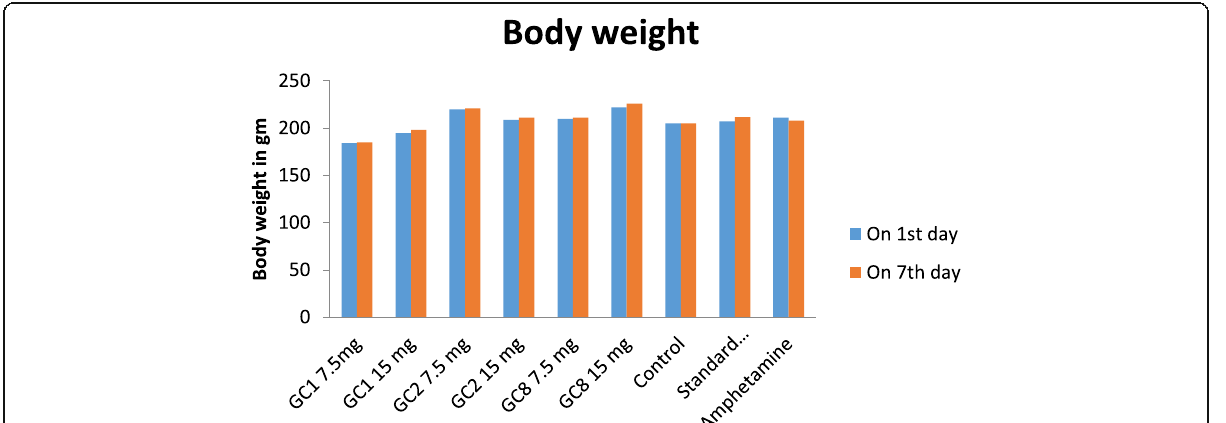
Fig. 1 Body weight of Wistar rats on the first and seventh day of the experiment